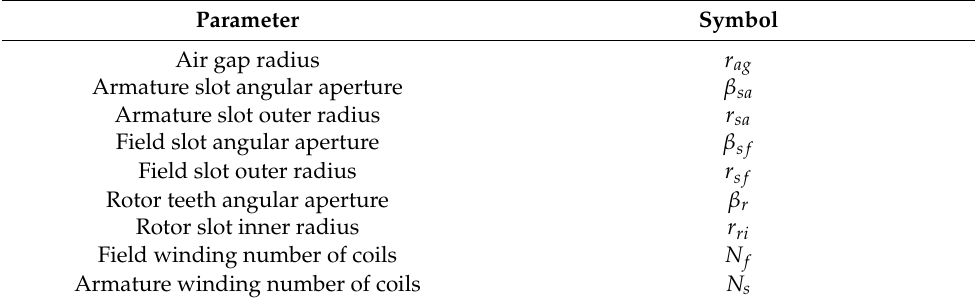
Table 1. FSM design variables.